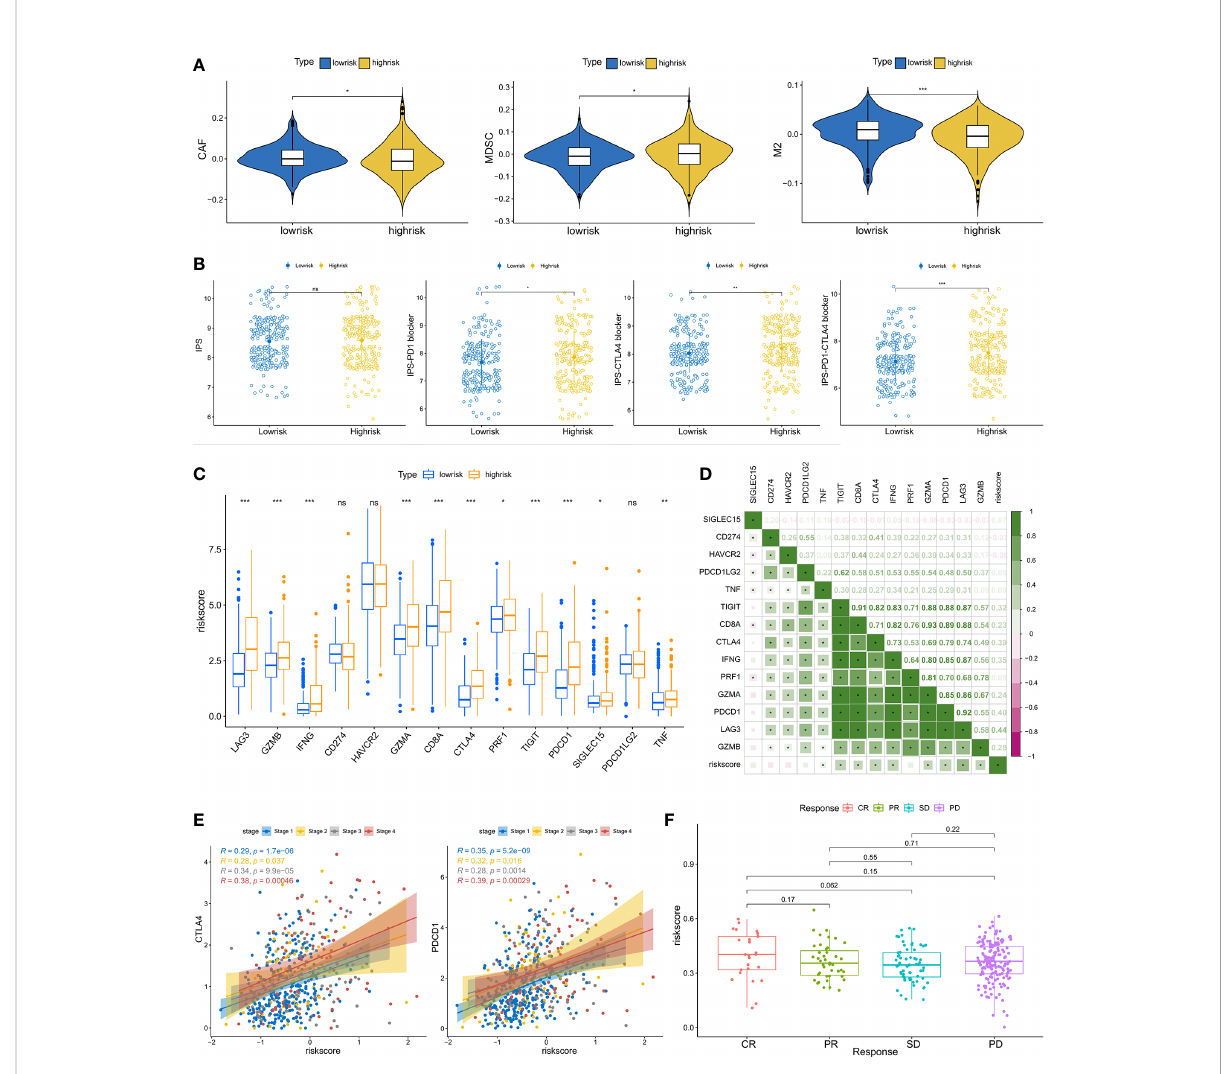
FIGURE 7 Predictive value of riskscore for immunotherapy: (A) The in fi ltration levels of CAFs, MDSCs, and M2-TAMs between the high- and low-risk groups. (B) The correlation between IPS and riskscore. (C) The expression of immune checkpoint genes in subgroups with high- and low-risk. (D) The association between riskscore and immune checkpoint gene expression. (E) The correlation between CTLA4, PD-1 expression and the riskscore in different pathologic stages. (F) The difference in riskscore among individuals in the IMvigor210 cohort performing different responses to immunotherapy. (*p < 0.05, **p < 0.01, ***p < 0.001). ns, no signi fi